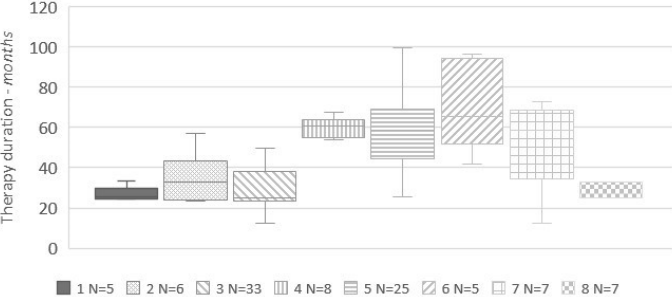
Figure 1. Distribution of the duration of adjuvant mitotane for each center (only centers with at least five patients have been included in this analysis). 1 = Berlin; 2 = Munich; 3 = Wurzburg; 4 = Florence; 5 = Orbassano; 6 = Padua; 7 = IGR (Villejuif); 8 = Montreal. N = number of patients.